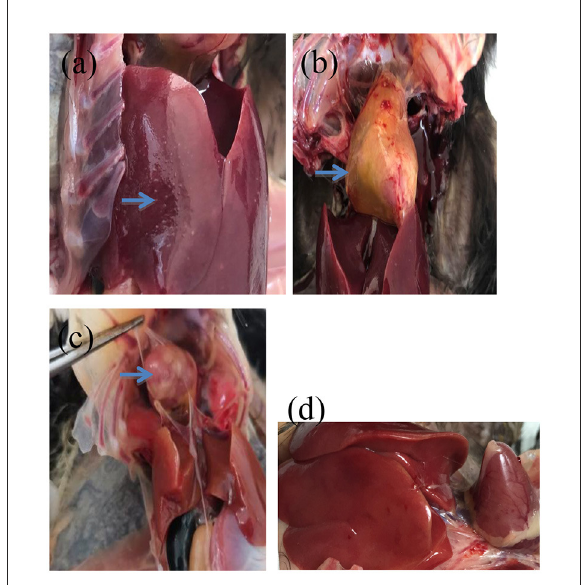
FIGURE1 The anatomic lesions of the challenged birds. (a) Liver with necrotic white foci on the surface (arrow). (b) Heart with pericardial effusion containing yellow cellulose exudates (arrow). (c) Heart with granuloma (arrow). (d) Blank control.